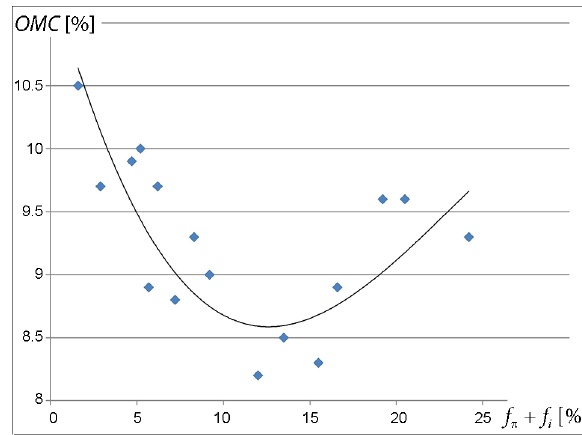
Figure 6. The dependence between optimum moisture content and the fine fractions